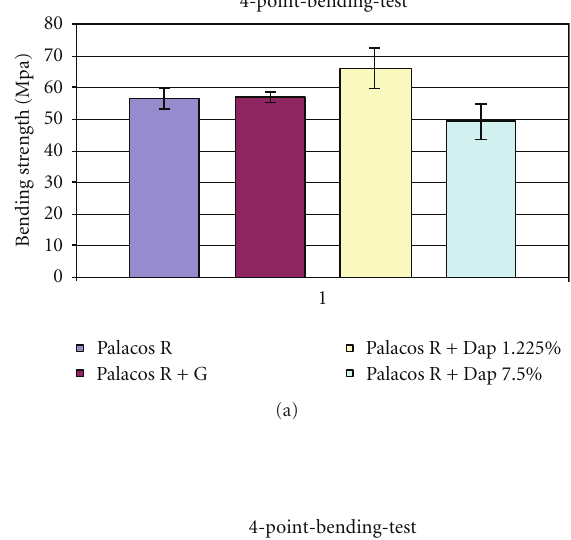
Figure 6: Elution kinetics for daptomycin measured by means of a bioassay with S. epidermidis and E.